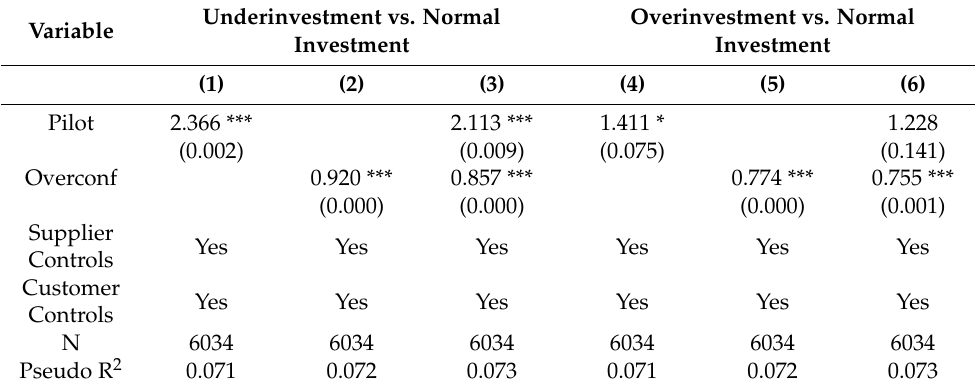
Table 7. Robustness tests: Multinomial logistic regressions.